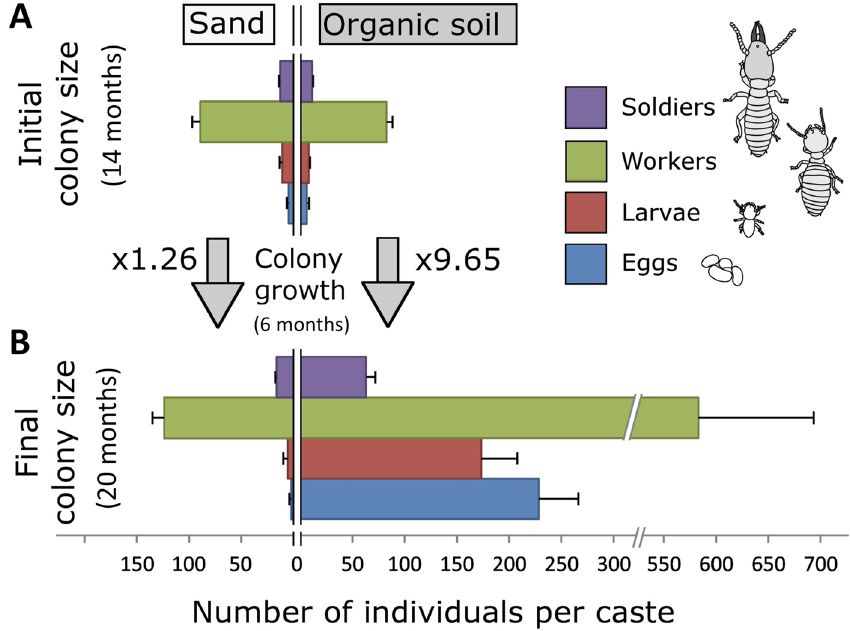
Figure 2. Colony size at ( A ) 14 months and ( B ) 20 months after two soil treatments. (average number of individuals ± SE, king and queen not presented). Total colony growth in sand condition was marginal (× 1.26 population increase, P = 0.032, t test), while substantial in organic soil (× 9.65 population increase, P < 0.001, t test). Comparisons of the average number of individuals for each independent castes at 20 month were all significantly higher in organic soil than in sand ( t test, α = 0.05).